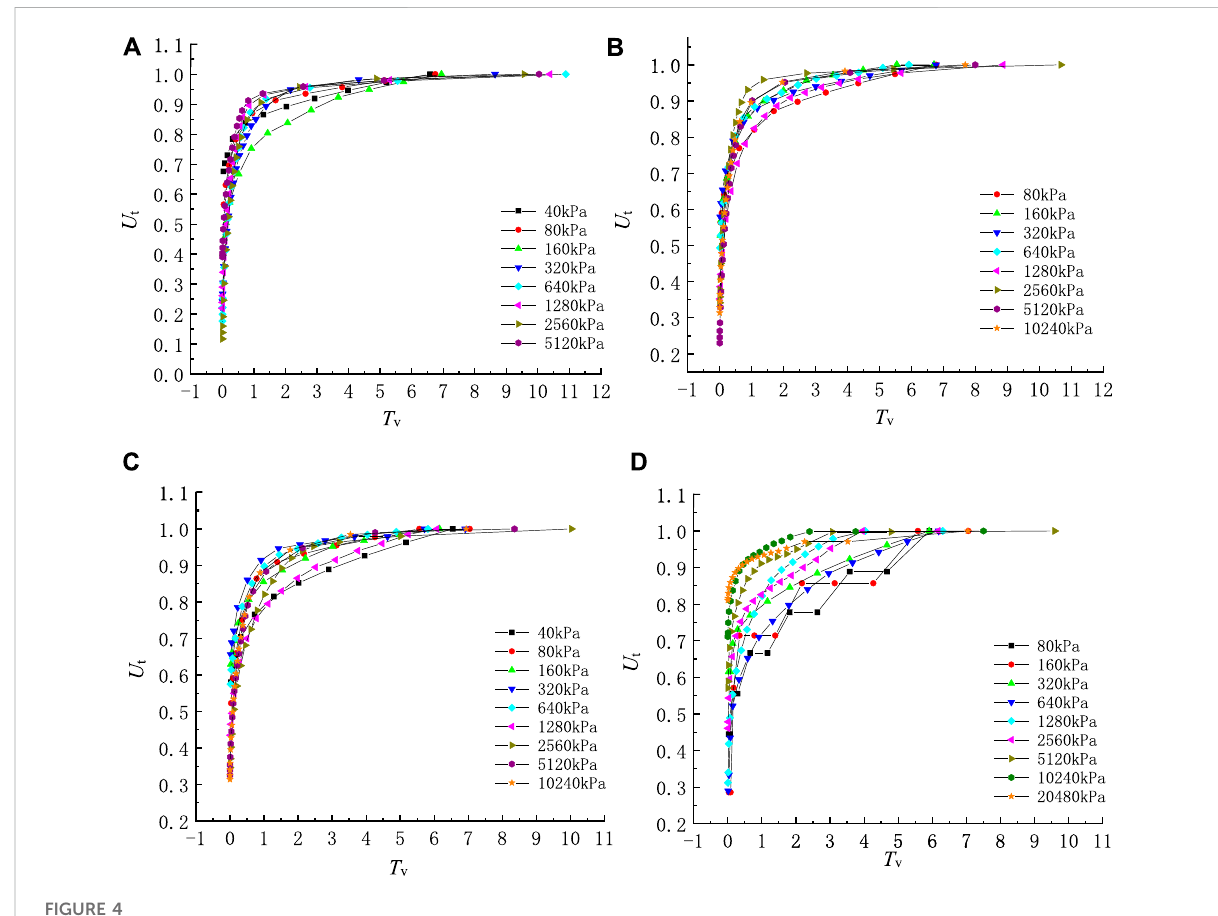
FIGURE 4 Relationship between U t and T v under different loads at sampling depths of 52.3 m (A) , 145.5 m (B) , 292.3 m (C) and 395.1 m (D)